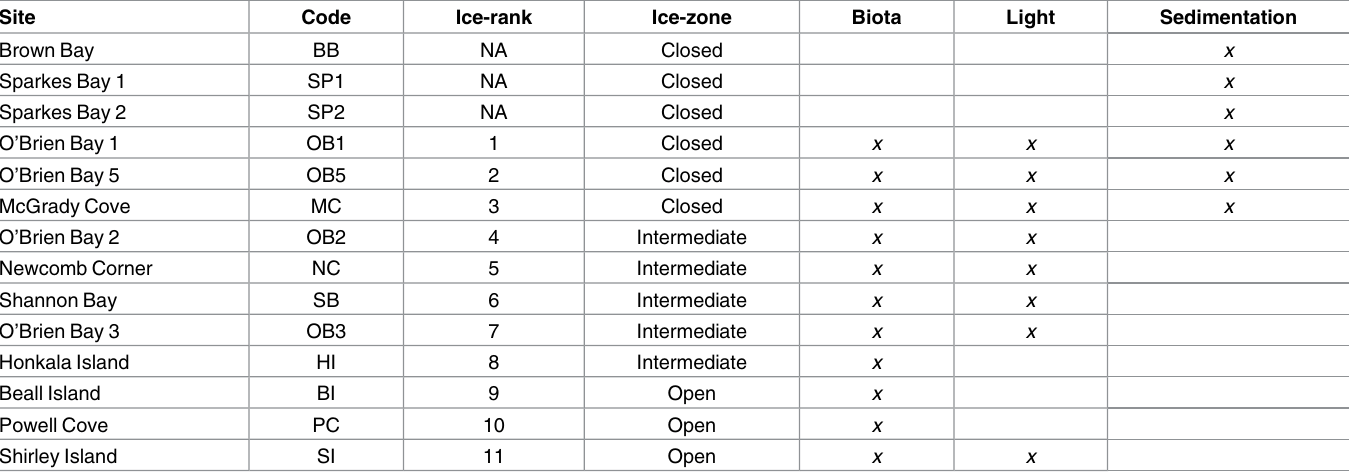
Table 1. Summaryof sea-ice conditions and types of data collected at each site (denoted by x ). Site codes are used in Fig 1. Ice-rank is an ordinal number given to sites where biota were sampled,basedon light measurements and long-term visual observations (NA refers sites where biota were not sam- pled). Lower numbers indicatelater sea-ice breakout. Ice-zone is a classification is given to all sites, for categorical analysesand to describe unranked